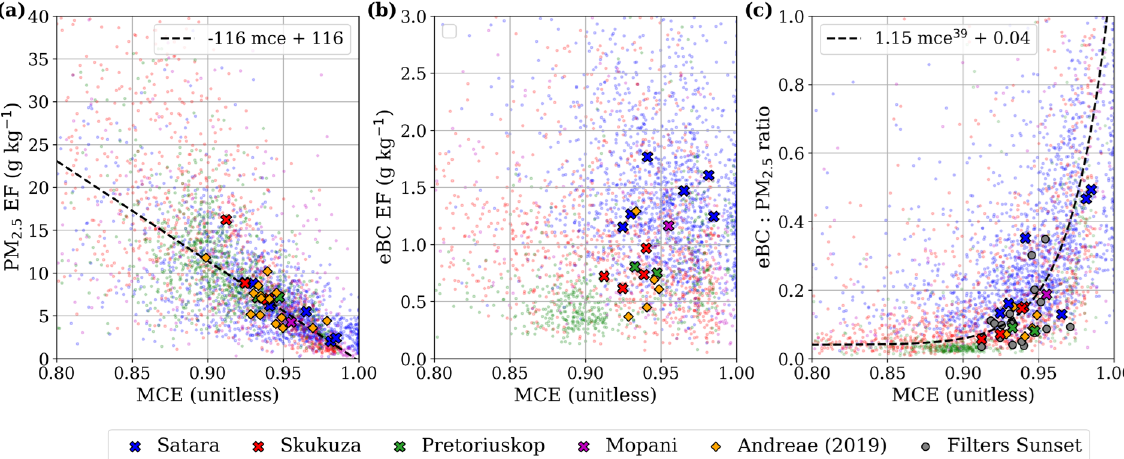
Figure 8. Relation between the PM 2 . 5 EF (a) the BC EF (b) and the eBC:PM 2 . 5 ratio (c) with the modified combustion efficiency (MCE) in the different KNP vegetation types. Each small dot represents a 1s measurement at the top of the mast. The large crosses represent the fire-average EF and the orange diamonds represent the study-average EF from previous savanna measurements listed by Andreae (2019). We found no significant correlation of eBC EF with the